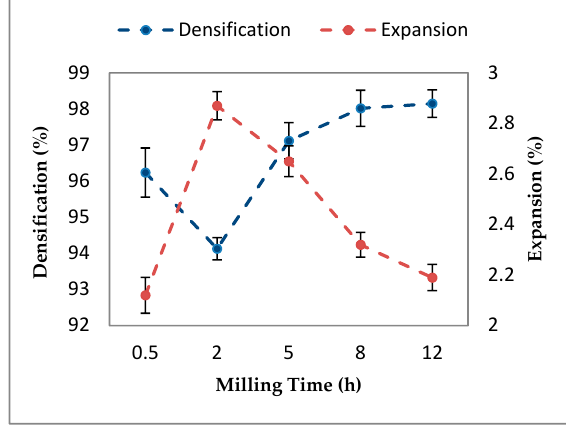
Figure 8. The variation of densification and expansion of Al-5Al 2 O 3 composites as a function of milling time.